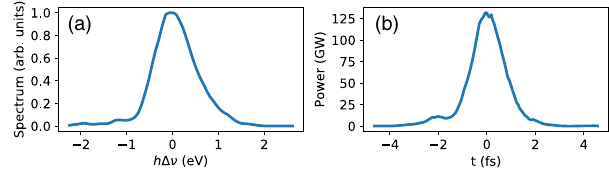
FIG. 17. (a) and (b) show one shot of the simulation with the single-dechirper setup in the spectral and the time domain,